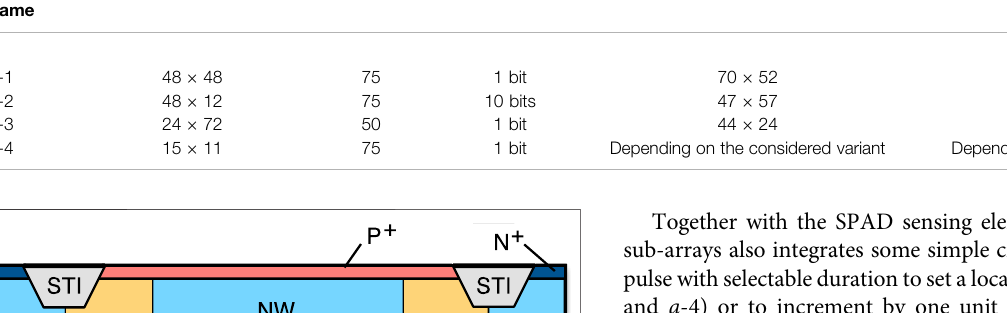
TABLE 1 | Main features of the sub-arrays in the FATHER and SON chips. Sub- array